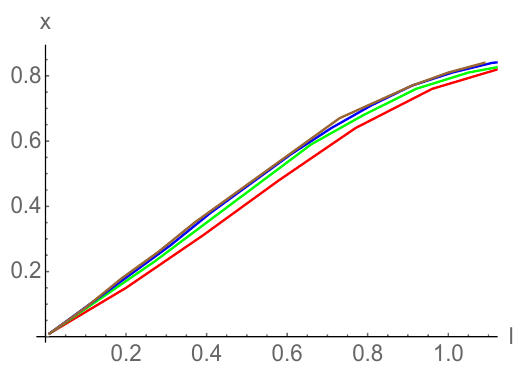
Figure 20 . n strip phase diagram in the de- con(cid:12)ned phase. Here T = 1 : 2 T c and (cid:22) = 0 : 45 are used and red, green, blue and brown curves correspond to n = 2, 3, 4 and 5 respectively. In units GeV.